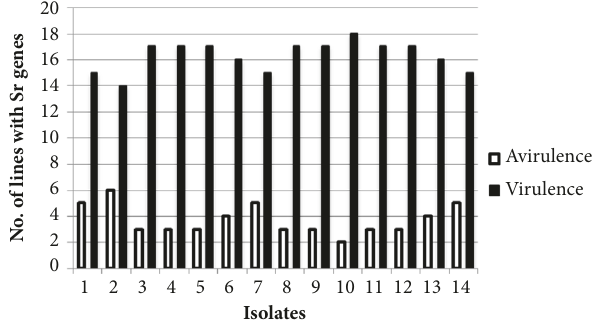
Figure 1: Response of differential lines to isolates of P. graminis f. sp . tritici . Isolates: 1= EH1; 2=EH2; 3=EH3; 4=EH4; 5=EH5; 6=EH6; 7=EH7; 8=EH8; 9=WH1; 10=WH2; 11=WH3; 12=WH4;